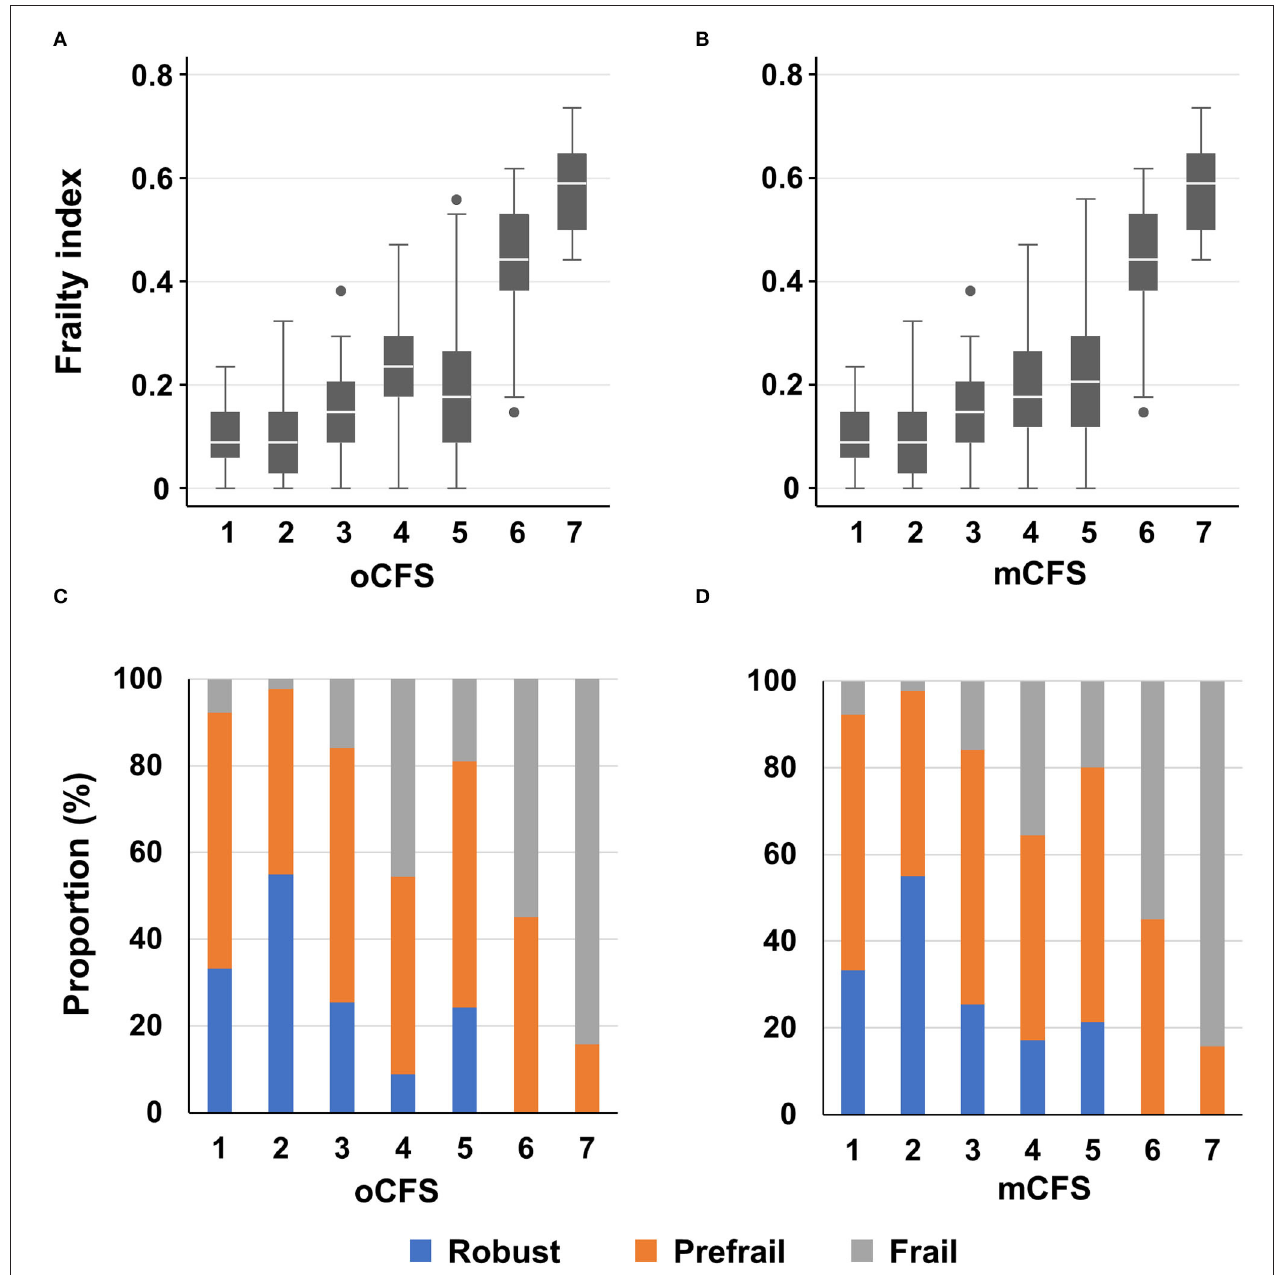
FIGURE 1 | Boxplots for frailty index according to clinical frailty scale scores, by original classification tree [oCFS, (A) ] and culturally modified classification tree [mCFS, (B)] , and bar plots showing the prevalence of the Cardiovascular Health Study frailty phenotype categories according to oCFS (C) and mCFS (D) ; In the box plot, the upper, mid, and lower lines denote 75th, 50th, and 25th percentiles and upper and lower margin of whiskers denote ± 1.5 interquartile range from the 50th percentile. Data outside the ± 1.5 interquartile range from the 50th percentile are shown as